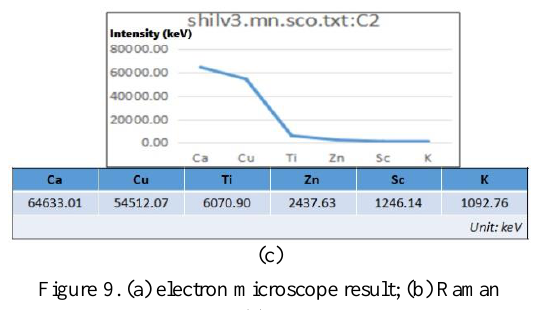
Figure 9. (a) electron microscope result; (b) Raman spectrometer result; and (c) portable X-ray fluorescence